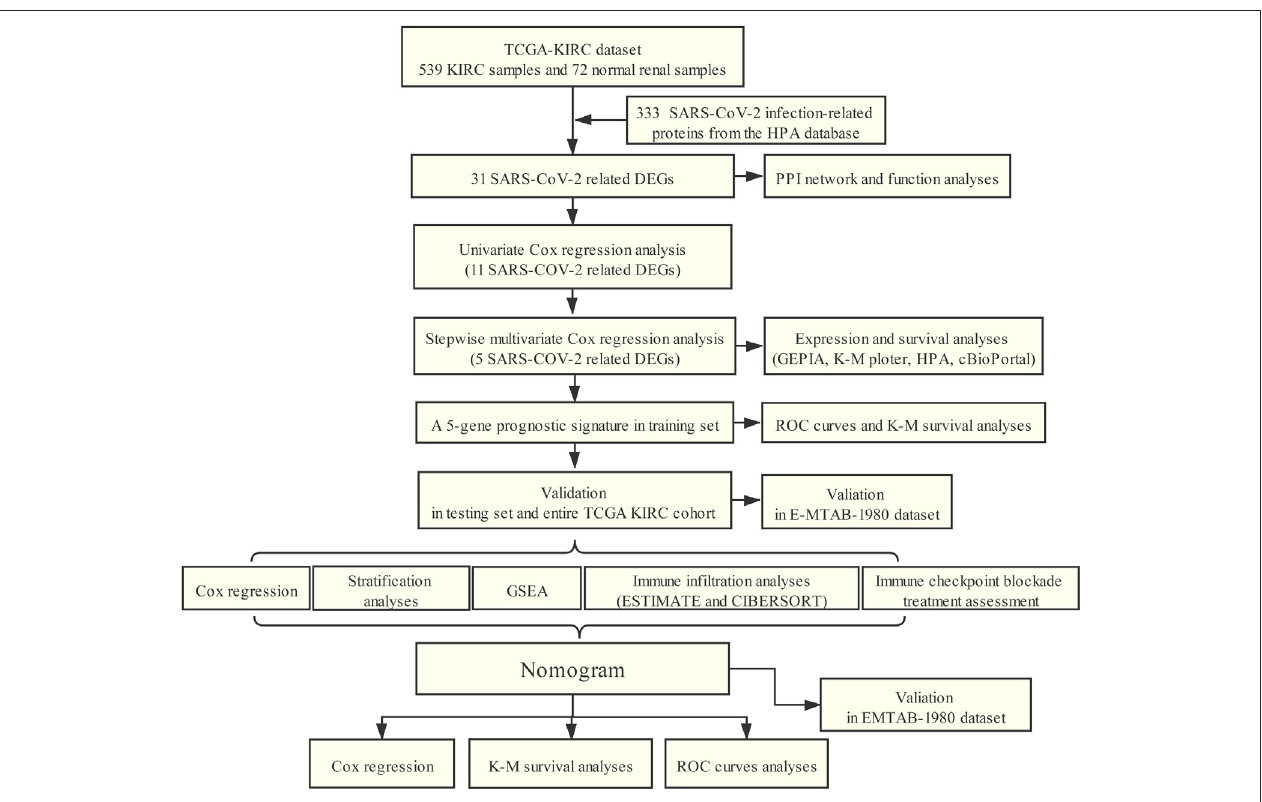
FIGURE 1 | Work fl ow of this